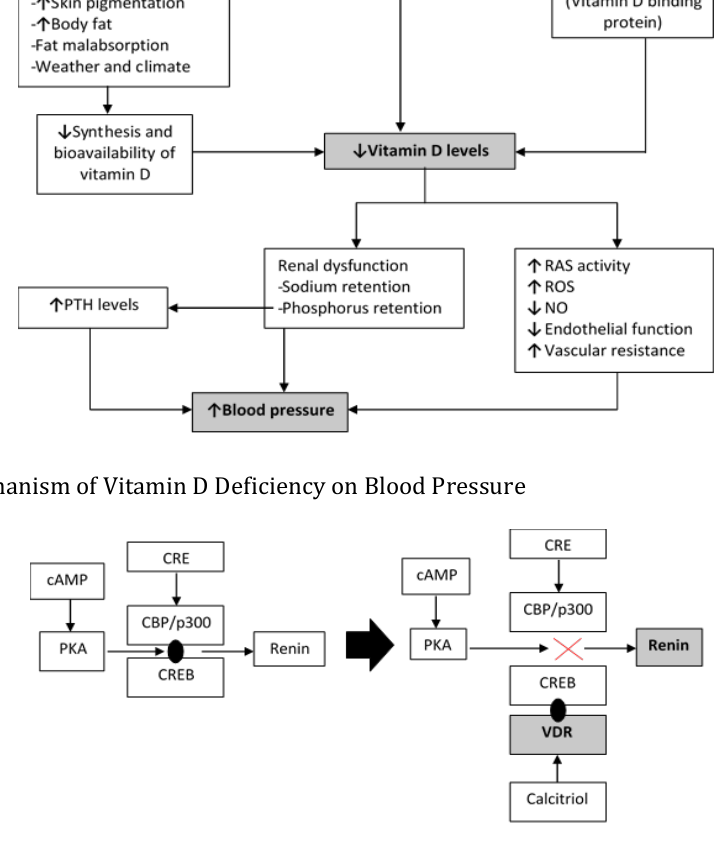
Figure 2. Vitamin D Inhibits the Transcription of the Renin